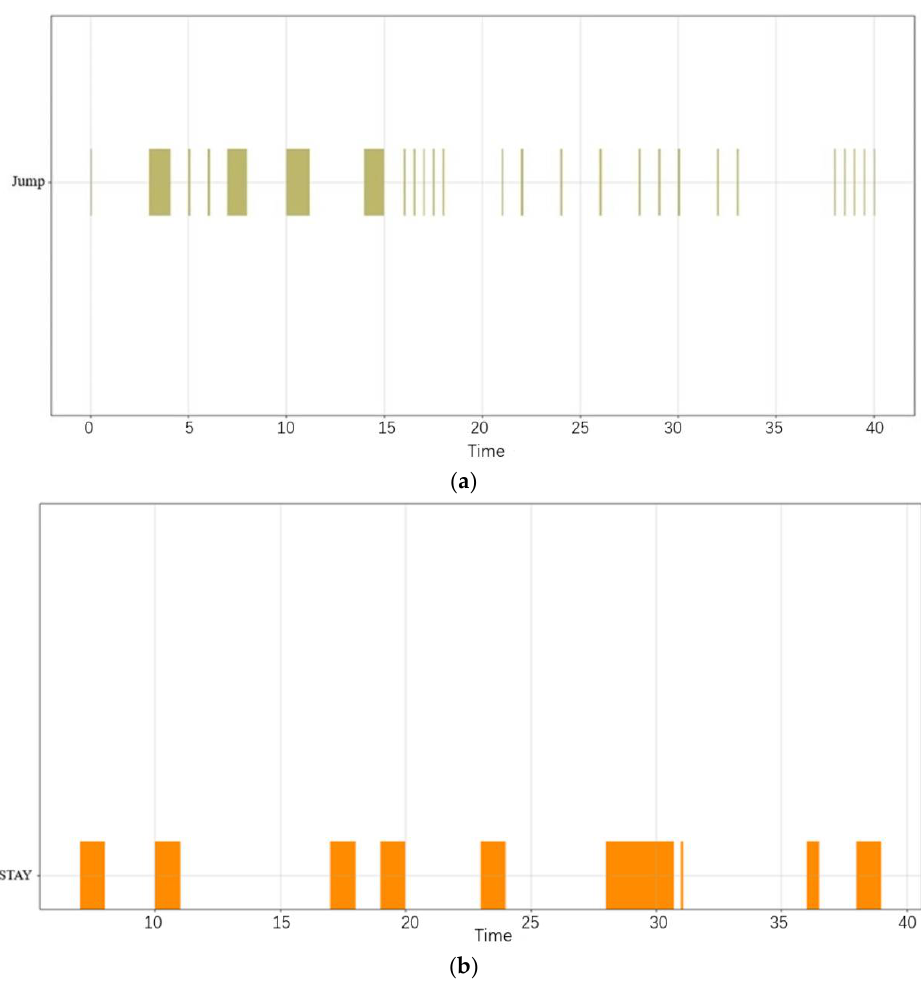
Figure 10. ( a ) The jumping behavior pattern of the cargo ship; ( b ) T he stay behavior pattern of the cargo ship. cargo